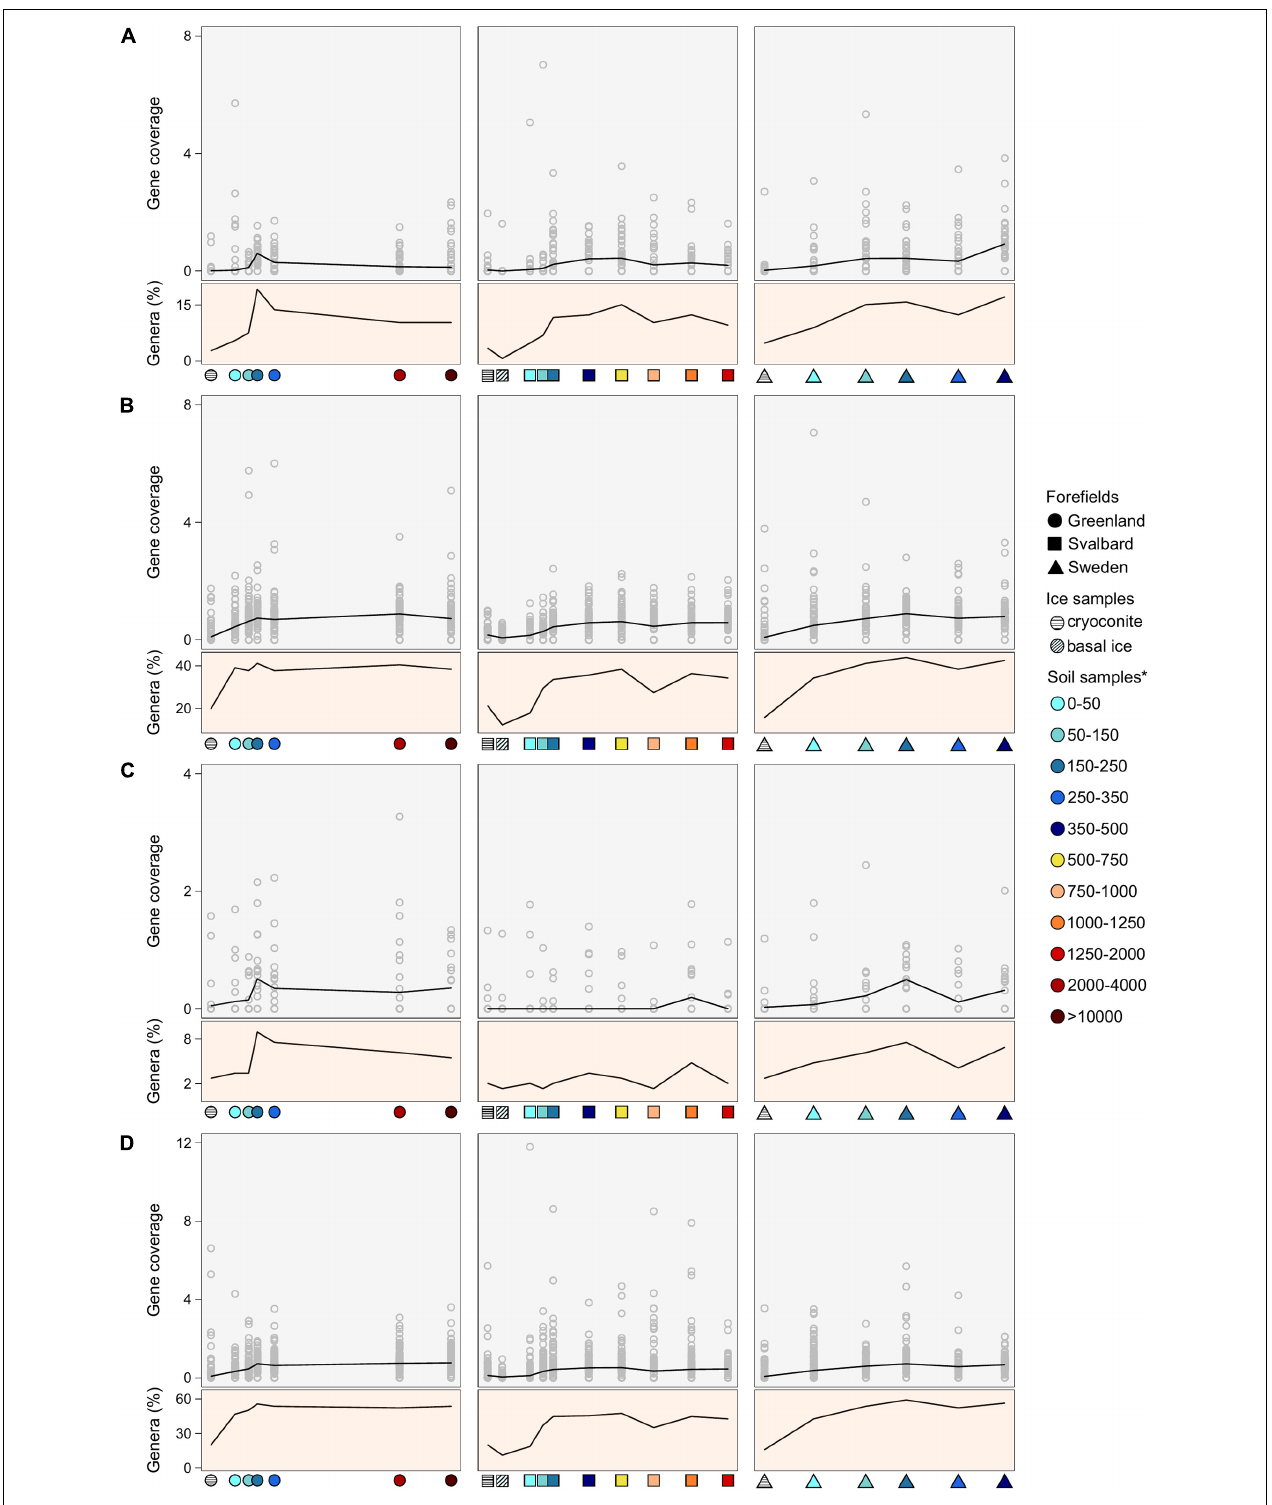
FIGURE 6 | Gene coverage and number of genera trends along the microbial succession for (A) nitrogenase genes, (B) obcA genes that are involved in oxalate biosynthesis, (C) cyanide synthase genes, and (D) siderophore-related genes. The percentage of genera is calculated as the number of genera that possess the studied gene divided by the total number of genera at a certain distance. *Soil samples are categorized in relation to their distance from the ice edge (m).